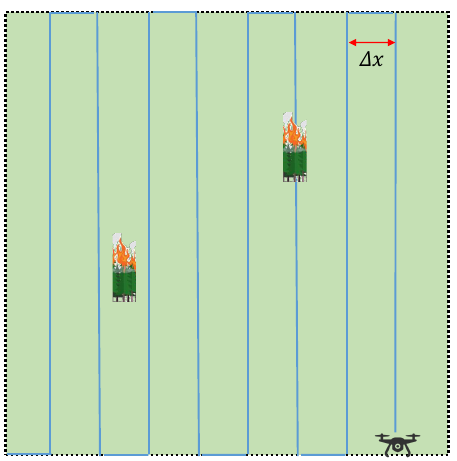
Figure 3. A graphical representation of the problem under consideration. The UAS patrol algorithm should be optimized to find the optimal flying path for detecting